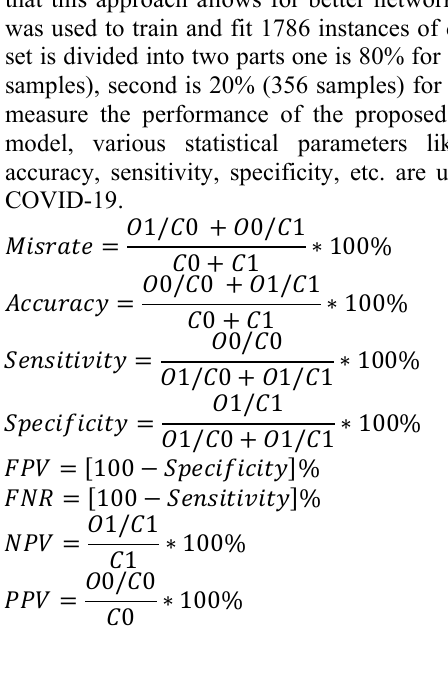
Table 1. Training accuracy of proposed TC2S-